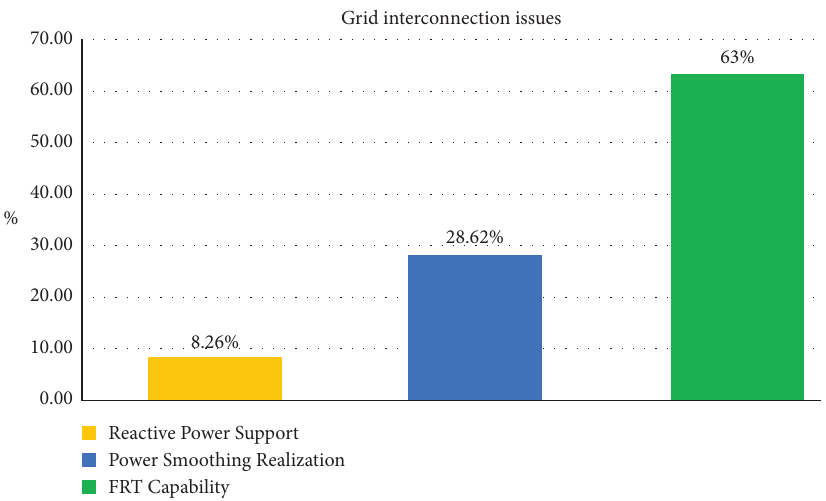
Figure 20: Percentage fgures for grid integration issue.